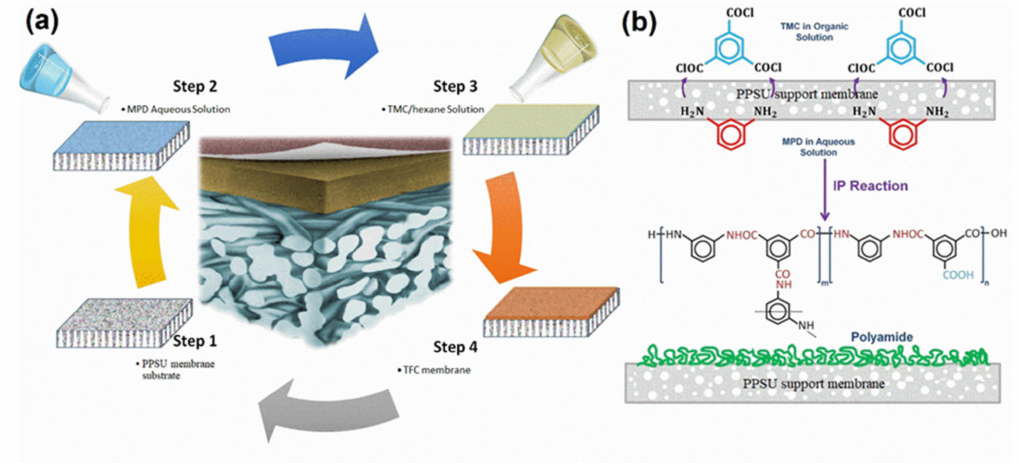
Figure 14. PPSU membrane surface modification schematic diagram: ( a ) steps in the modification process; ( b ) interfacial polymerization reaction mechanisms during the formation of the TFC